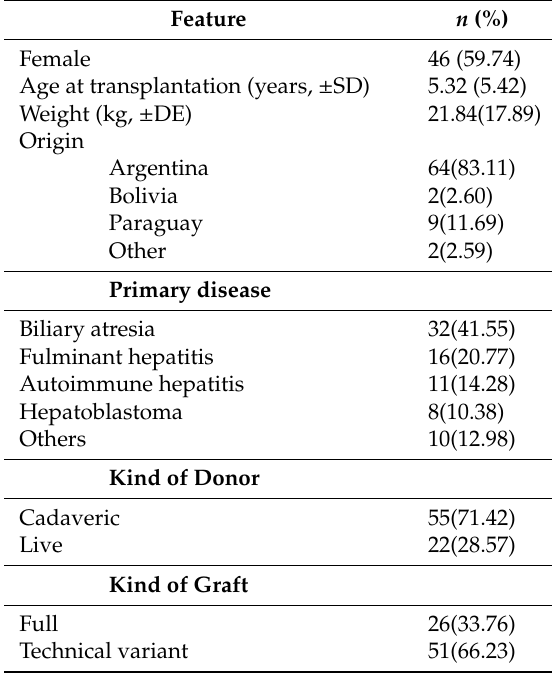
Table 1. Characteristics of the studied population ( n = 77).